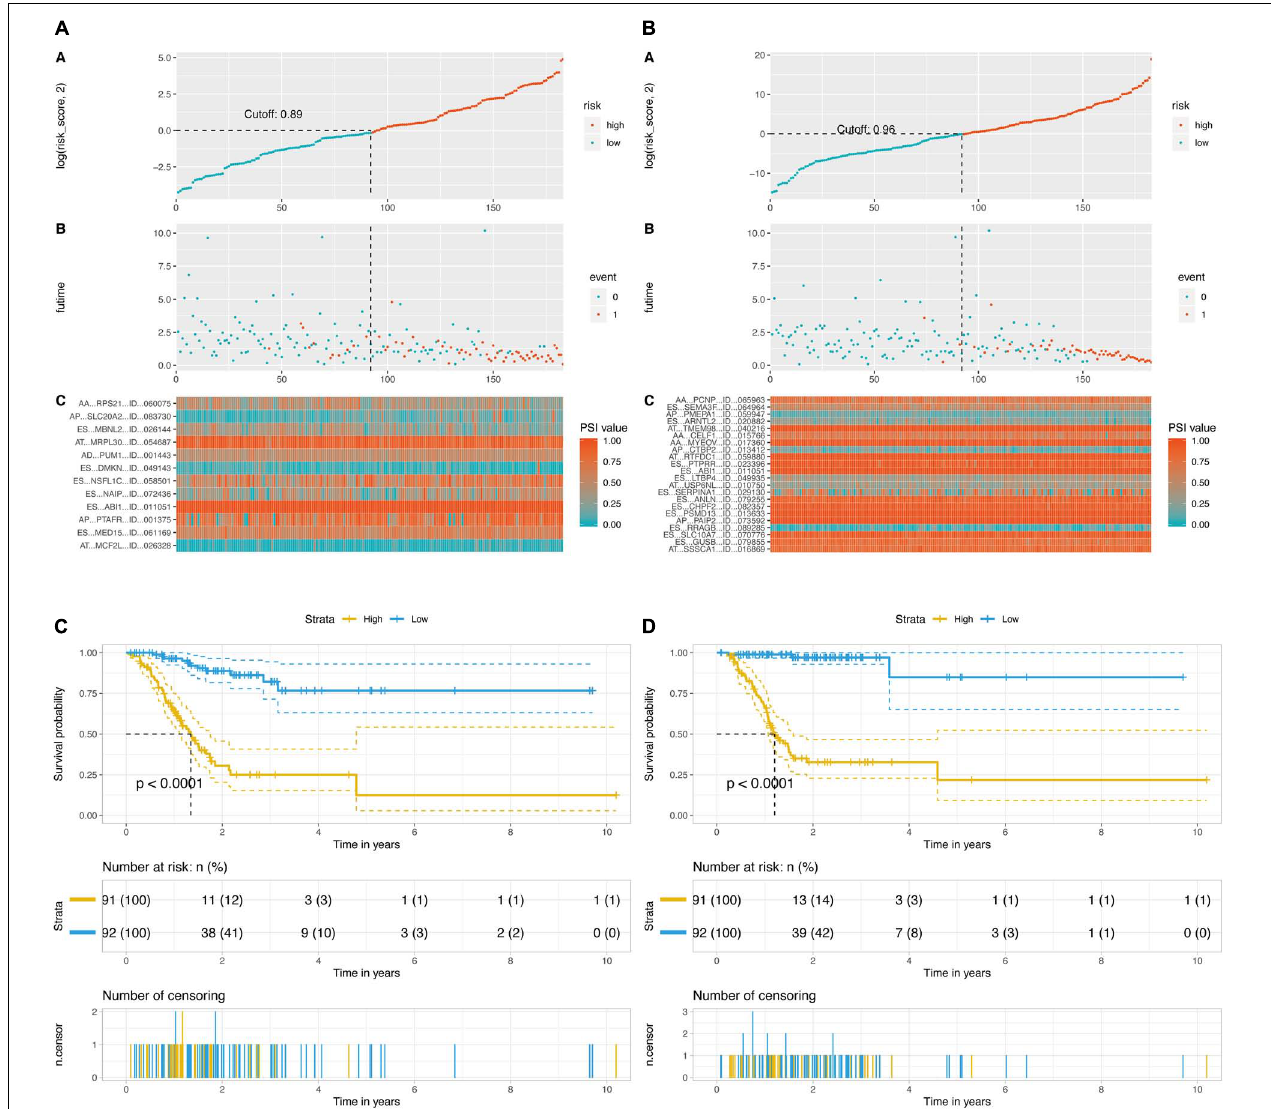
FIGURE 5 | Determination and analysis of the final prognostic models. (A) OS-related prognostic model. (B) DFS-related prognostic model. High- and low-risk groups were divided based on the median value of risk score. The upper plot illustrated assignment of patients’ survival status and survival times, the middle plot showed the risk score curve, and the bottom heatmap represented splicing distribution of the AS in compound prognostic models. Color transition from blue to red indicates the increasing PSI value of corresponding AS event from low to high. (C) KM plot of OS-related prognostic model. (D) KM plot of DFS-related prognostic model. The figure contains three parts: [1] survival differences estimated by Kaplan-Meier survival curve; [2] number of patients in different groups; and [3] number censored at different